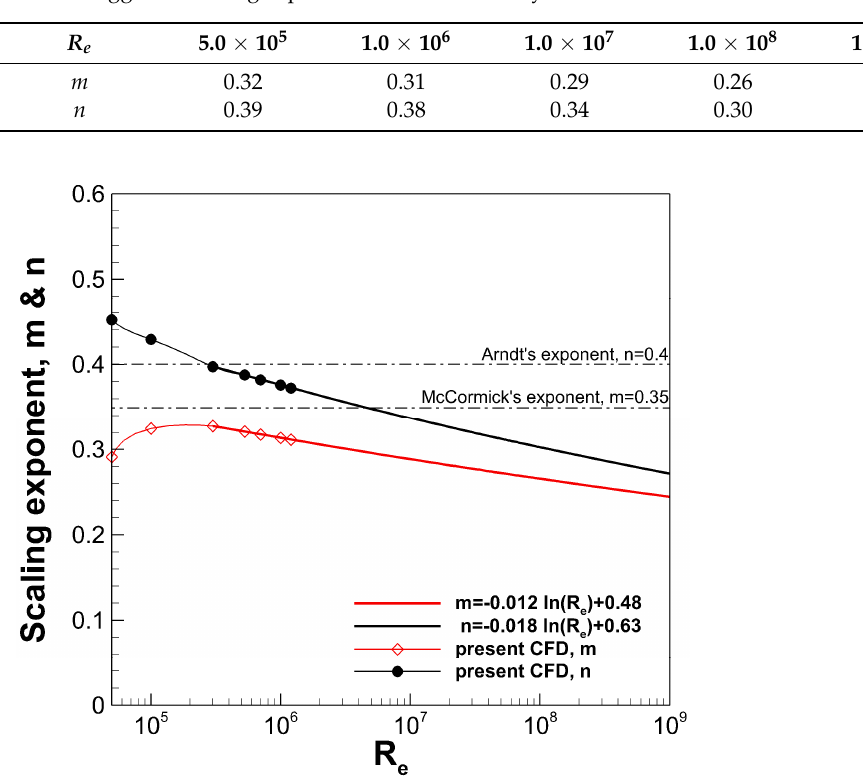
Figure 21. Suggested scaling exponents in weak water as a function of the Reynolds number for different scaling laws.